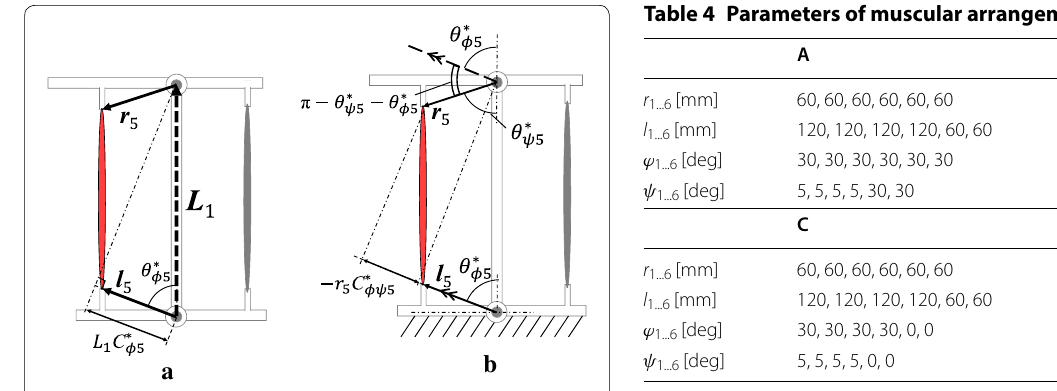
Fig. 8 Geometric relationship for the condition (37) of the 5th biarticular muscle